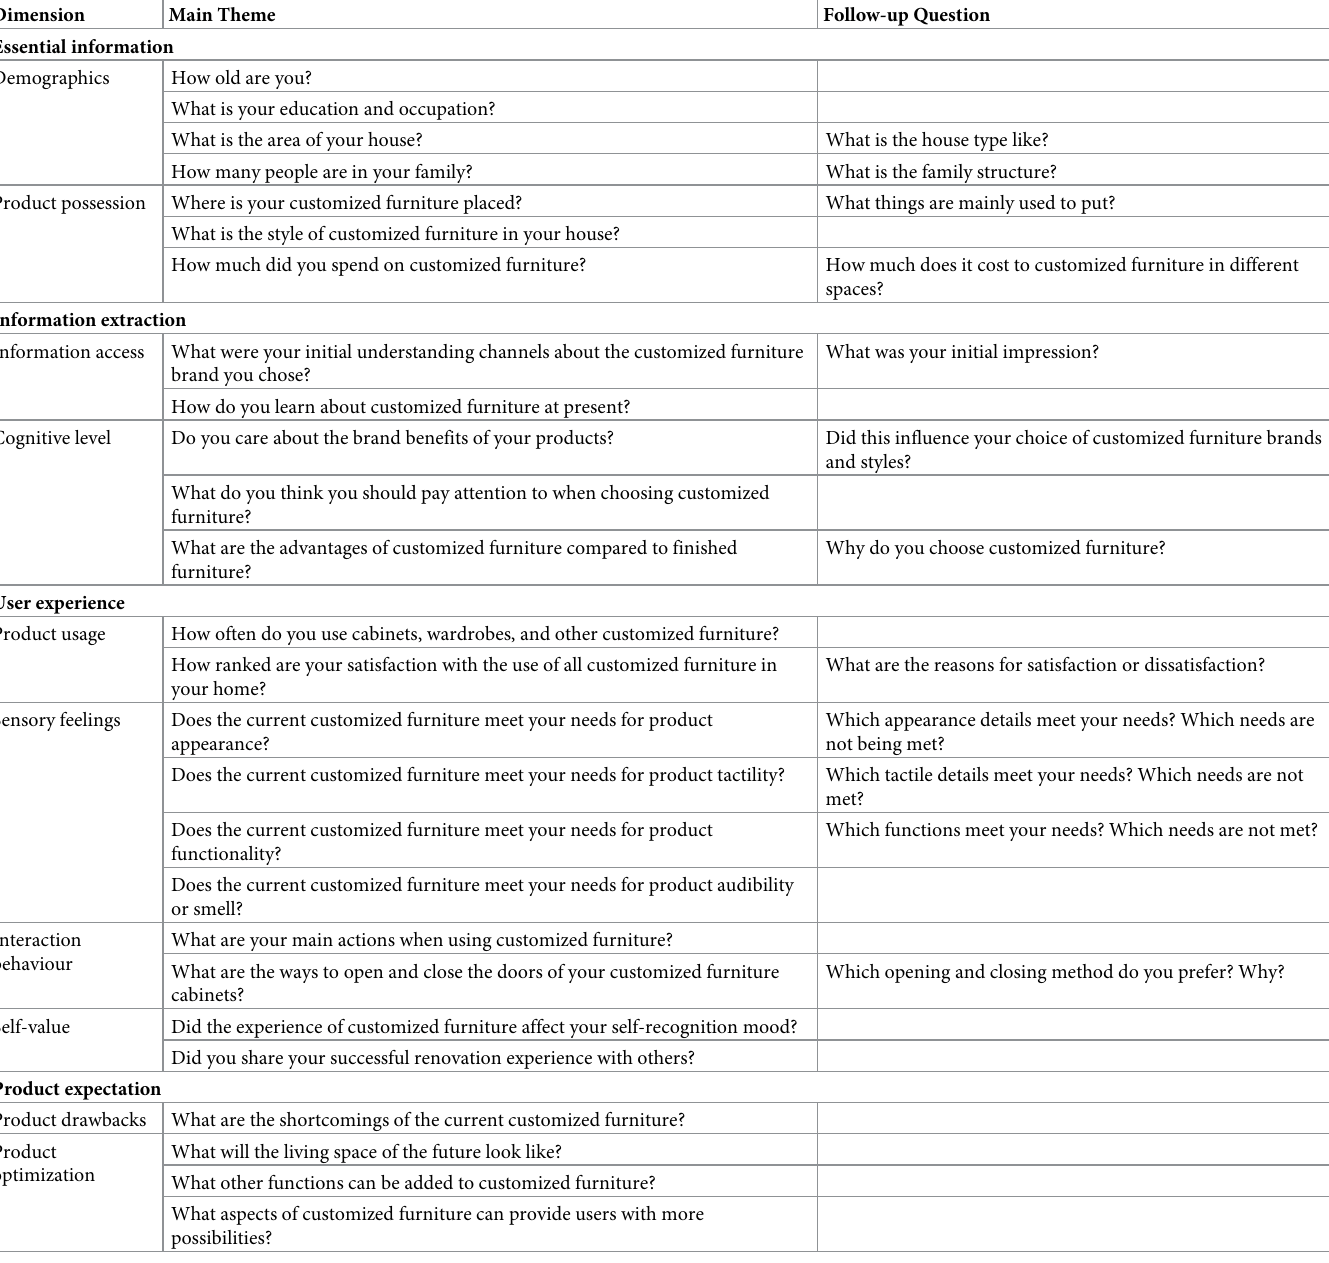
Table 1. Customized furniture 4E interview